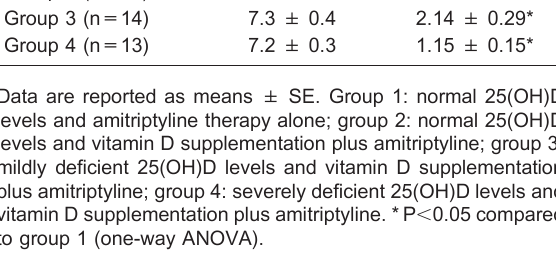
Table 2. Number of migraine attacks in pediatric patients before and after treatment. Groups Before After Group 1 (n=13) 7.0 ± 0.12 3.0 ± 0.25